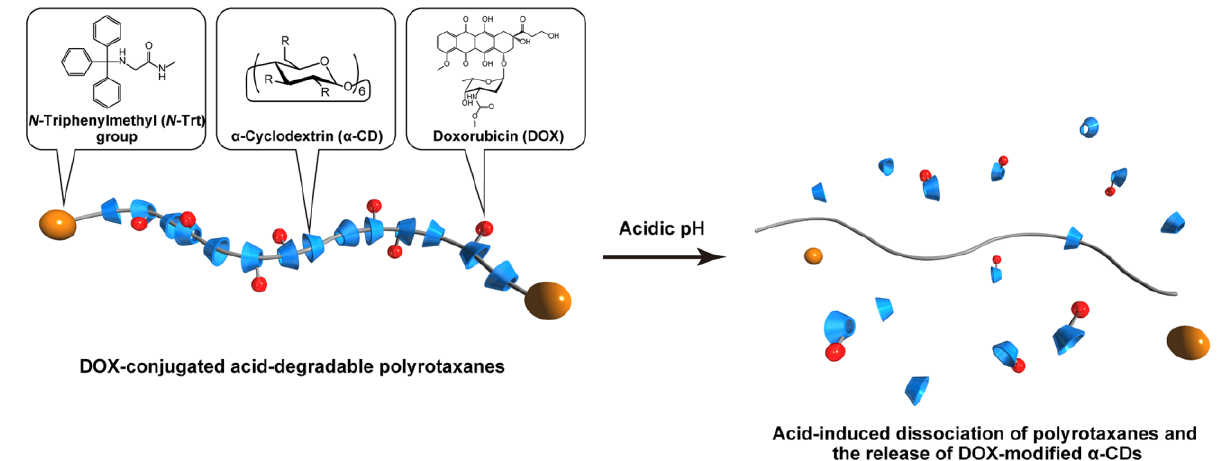
Figure 1. Schematic illustration of acid-degradable polyrotaxane (PRX)–drug conjugates and their acid-induced dissociation.